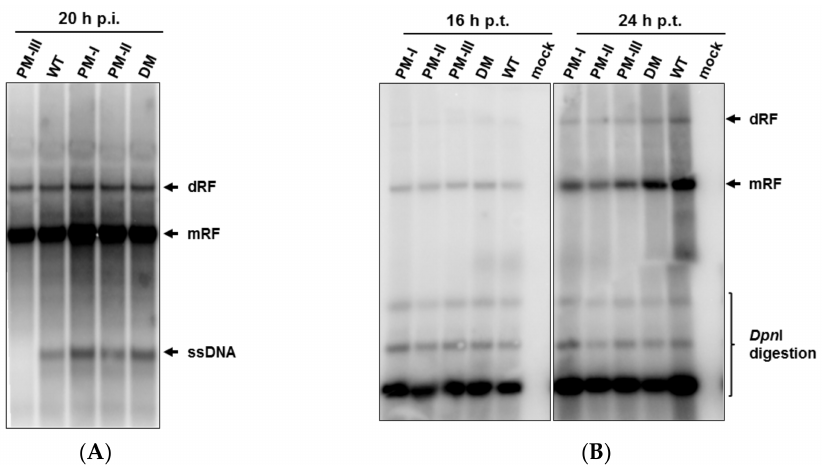
Figure 6. Accumulation of viral DNA replicative forms in infected or transfected NB-324k cells with the mutants. ( A ) Accumulation of DNA replicative forms in NB-324k cells infected with wt H-1PV and derived mutants. NB-324K cells (1.6 × 10 6 ) were infected (MOI, 1 PFU/cell) with wt H-1PV, H1-PM-I, -II, -III, and –DM and further incubated in the presence of neutralizing antibodies. At 20 h post-infection, cells were harvested and viral DNA replicative forms were purified from cell lysates, separated by agarose gel electrophoresis, and subjected to Southern blotting. The bands corresponding to single-stranded, monomeric, and dimeric replicative forms of viral DNA are indicated as ssDNA, mRF, and dRF, respectively ( A ); ( B ) DNA replicative forms in NB-324k cells transfected with the plasmids pH1 (wt) or mutant derivatives. NB-324k cells (1 × 10 6 cells) were transfected with 6 µ g of pH1, pH1-PM-I, pH1-PM-II, pH1-PM-III, and pH1-DM and further incubated with neutralizing antibodies. Cells were harvested at indicated times post-transfection and viral DNA replicative forms purified from cell lysates were DpnI digested and analyzed by Southern